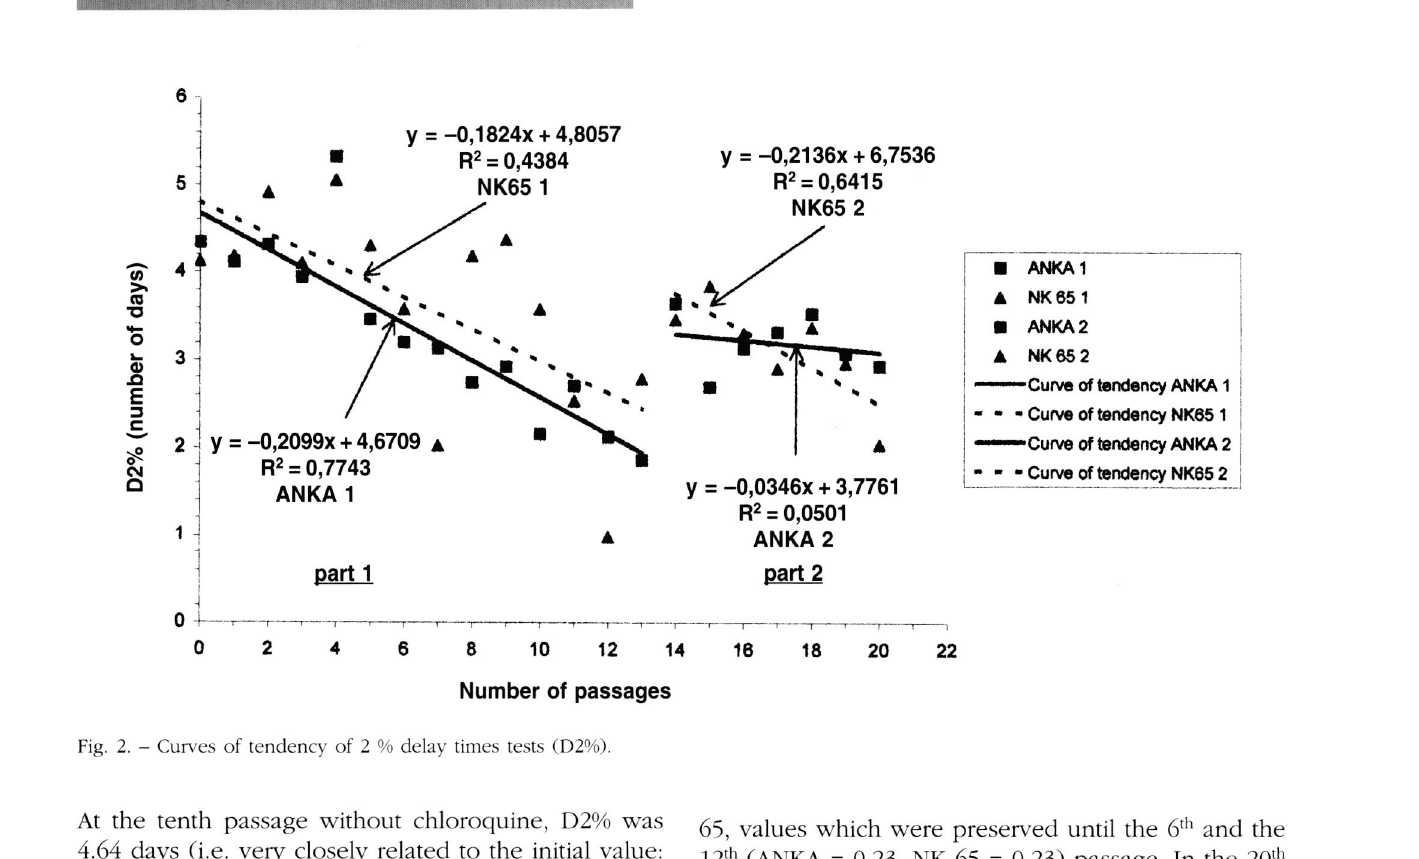
Fig. 2. - Curves of tendency of 2 % delay times tests (D2%).